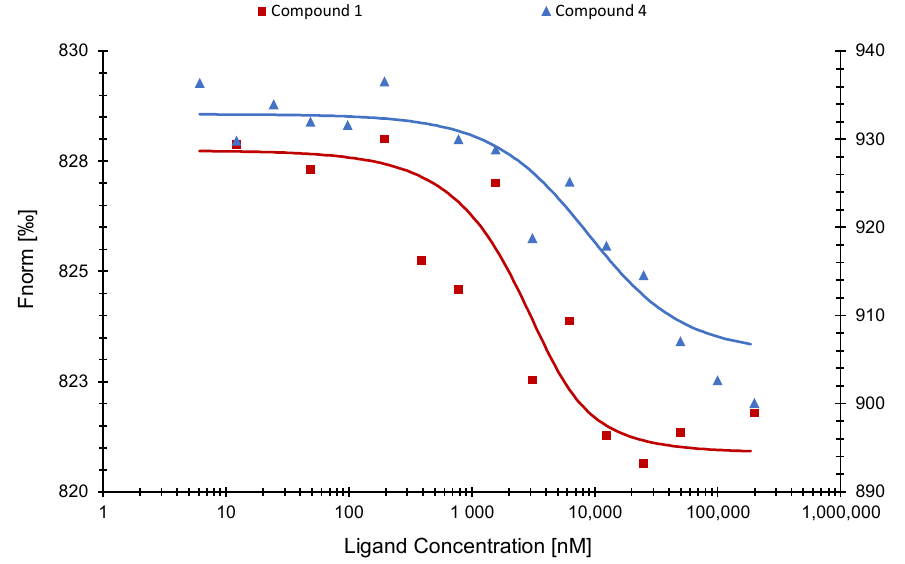
Figure 5. Binding curves of SARS-CoV-2 NP NTD with compounds ( 1 ) ( left axis ) and ( 4 ) ( right axis ) as determined by microscale thermophoresis.